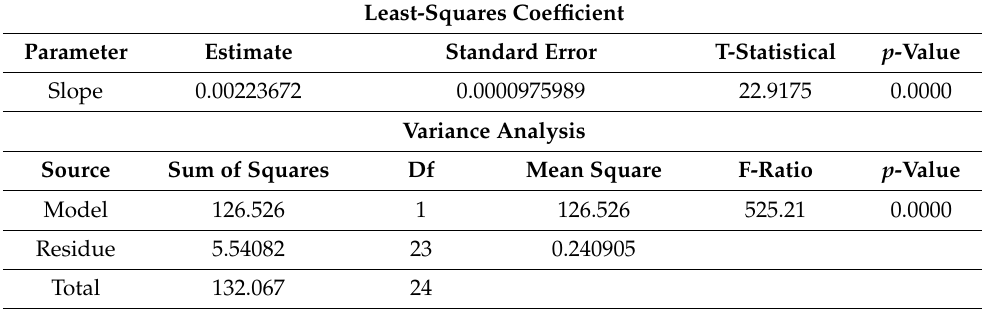
Table 4. Simple regression—Mn vs. conductivity.